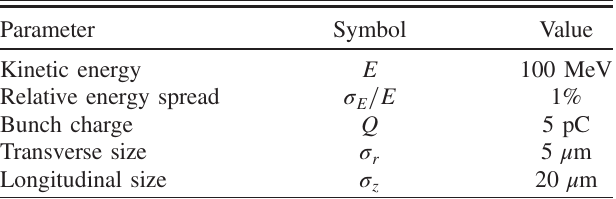
TABLE II. Electron bunch parameters considered in the numerical simulations.